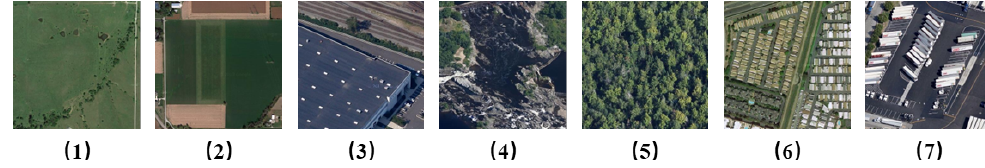
Figure 7. Example images of the RSSCN7 dataset: ( 1 ) Grass, ( 2 ) Field, ( 3 ) Industry, ( 4 ) River Lake, ( 5 ) Forest, ( 6 ) Resident, ( 7 ) Parking.